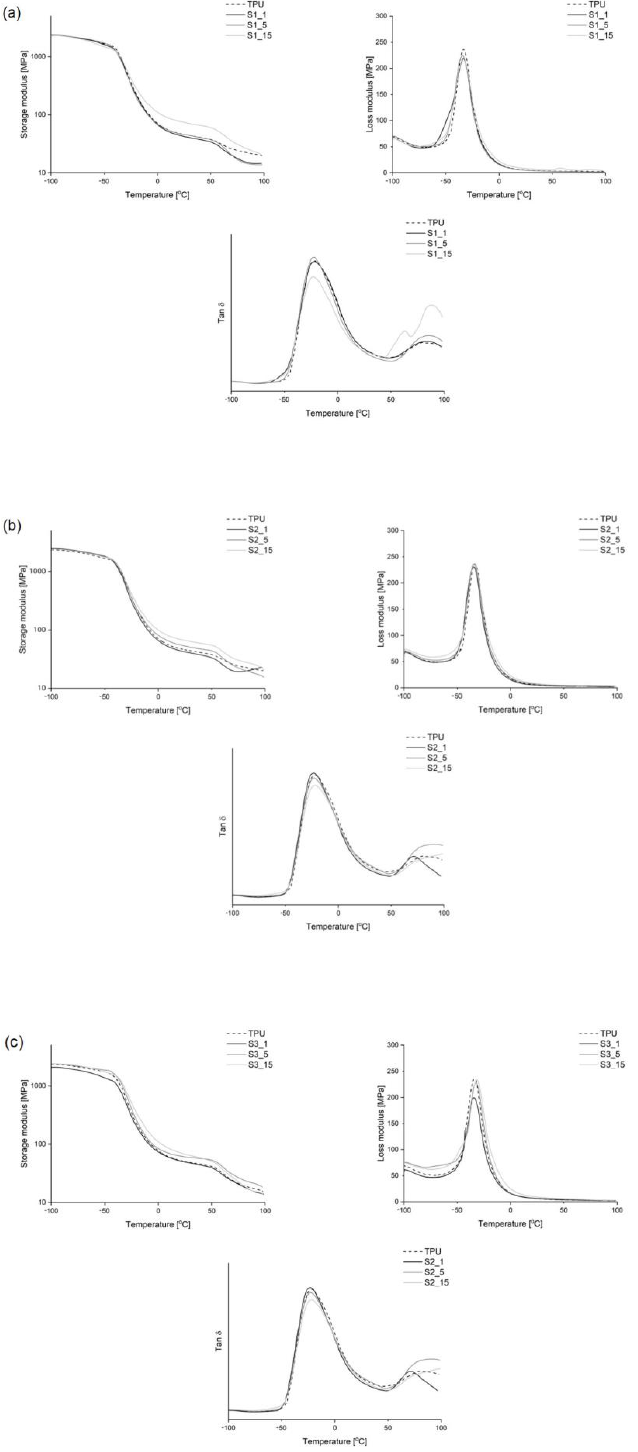
Figure 6. The storage (E’), loss modulus (E”) and tan δ in the function of temperature for bio-TPU- ABW composites: ( a ) series S1, ( b ) series S2 and ( c ) series